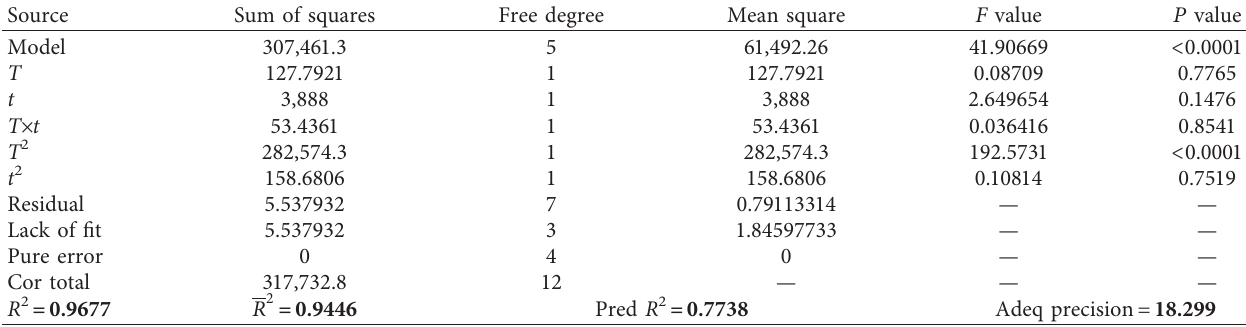
Table 6: Analysis of variance (ANOVA) for the tensile strength.